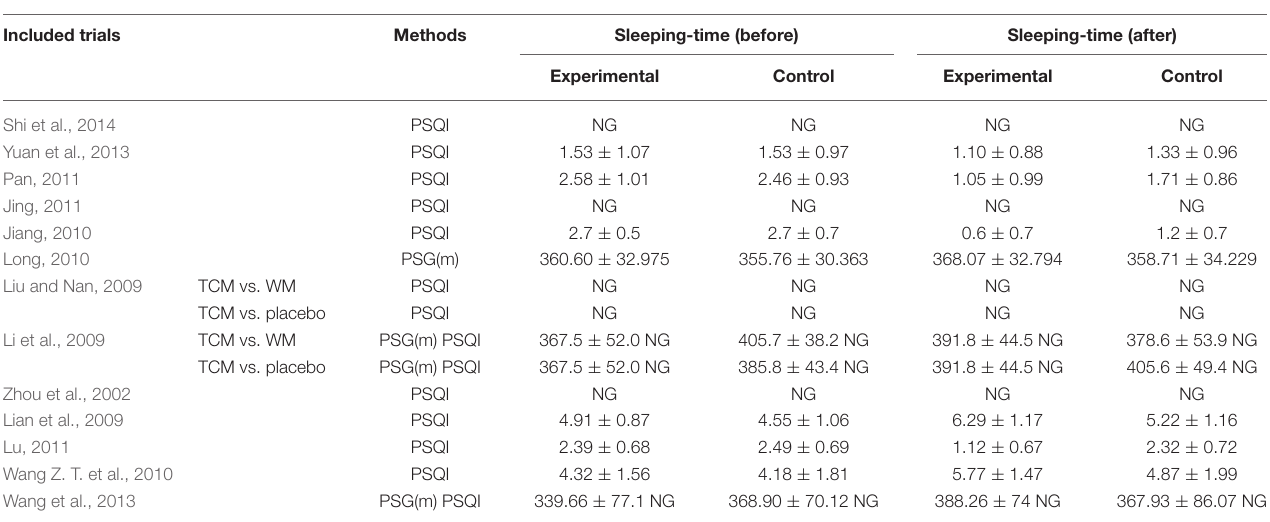
TABLE 4 | Characteristics of the Sleeping time of included